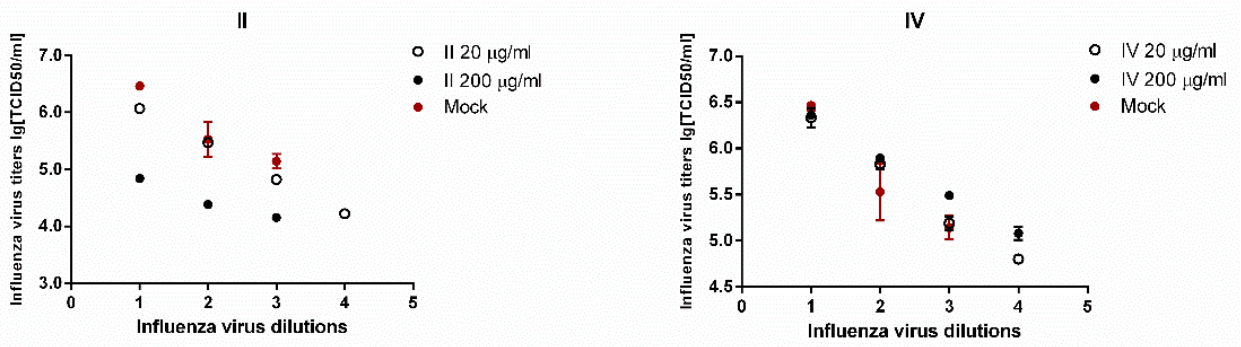
Figure 5. The dose-dependent antiviral effect obtained for compounds II and IV .